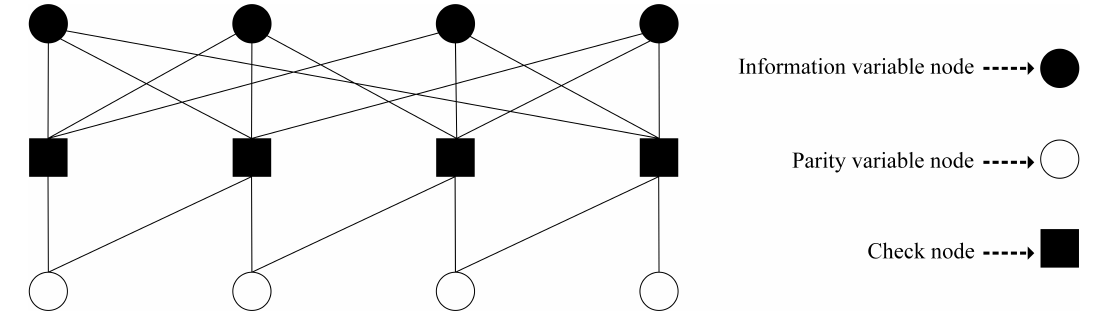
Figure 3. A Tanner graph representation of a repeat accumulate code with ( q , a ) = ( 3,3 ) . In the graph, filled and unfilled circle nodes represent the information and parity bits, respectively, while rectangular nodes represent check